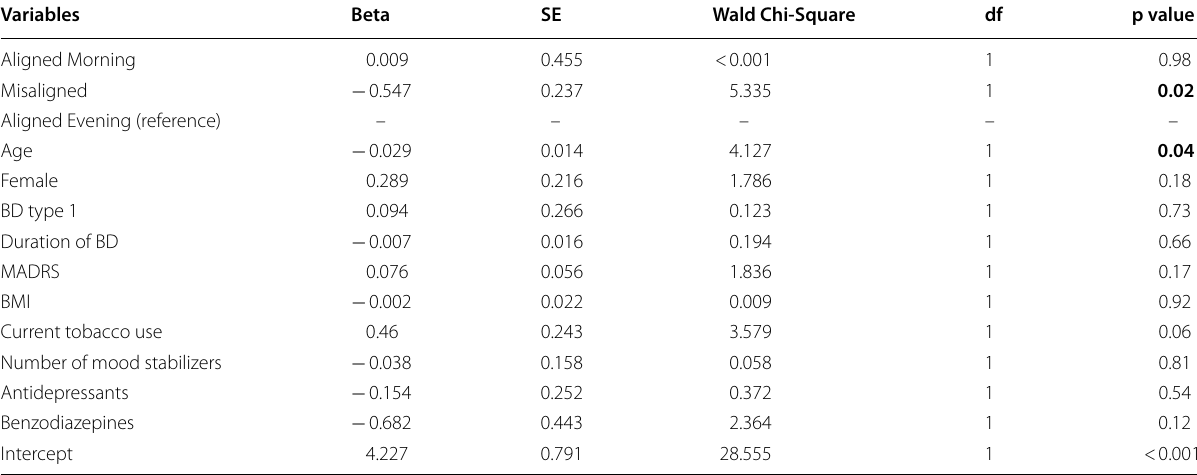
SE: Standard Error, df: degree of freedom, BD: Bipolar Disorder, MADRS: Montgomery Asberg Depression Rating Scale, BMI Body Mass